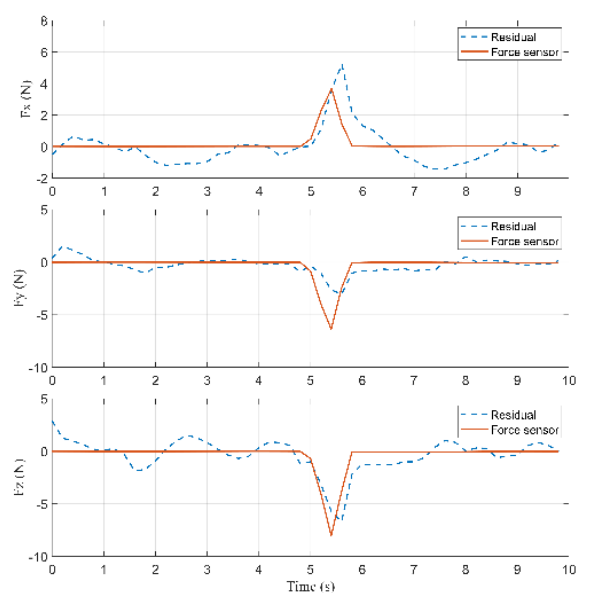
Figure 16. Comparison of the residuals for the force sensor in Case 2.